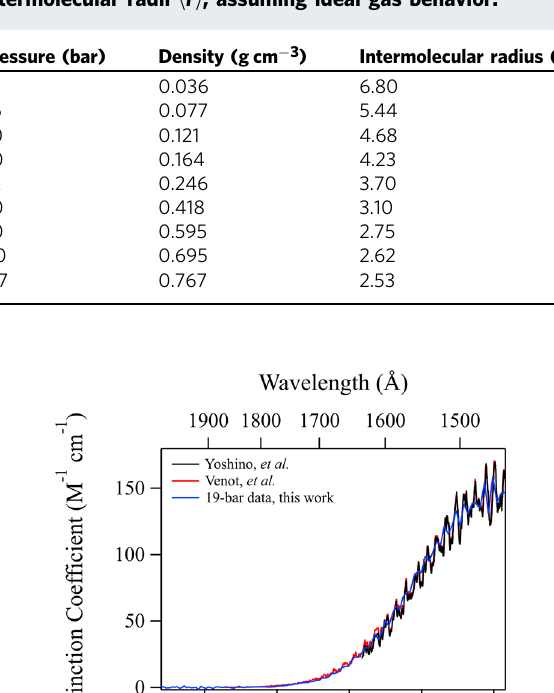
Table 1 Pressures and corresponding densities for all supercritical CO 2 spectra acquired, and estimated average intermolecular radii r h i , assuming ideal gas behavior.